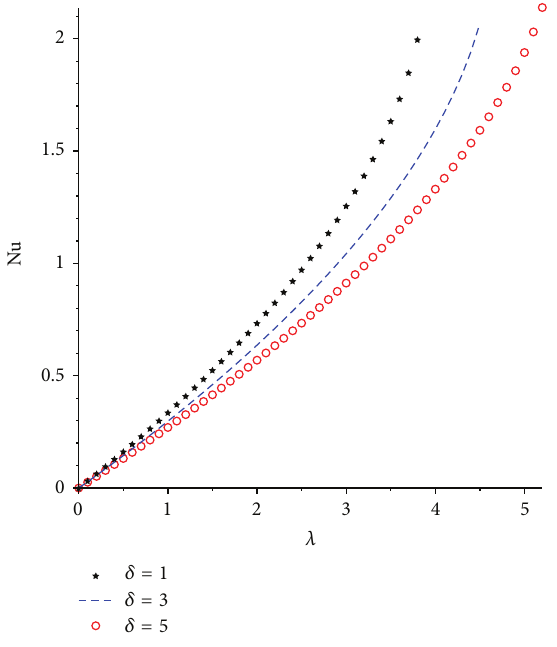
Figure 6: 𝛿 on thermal